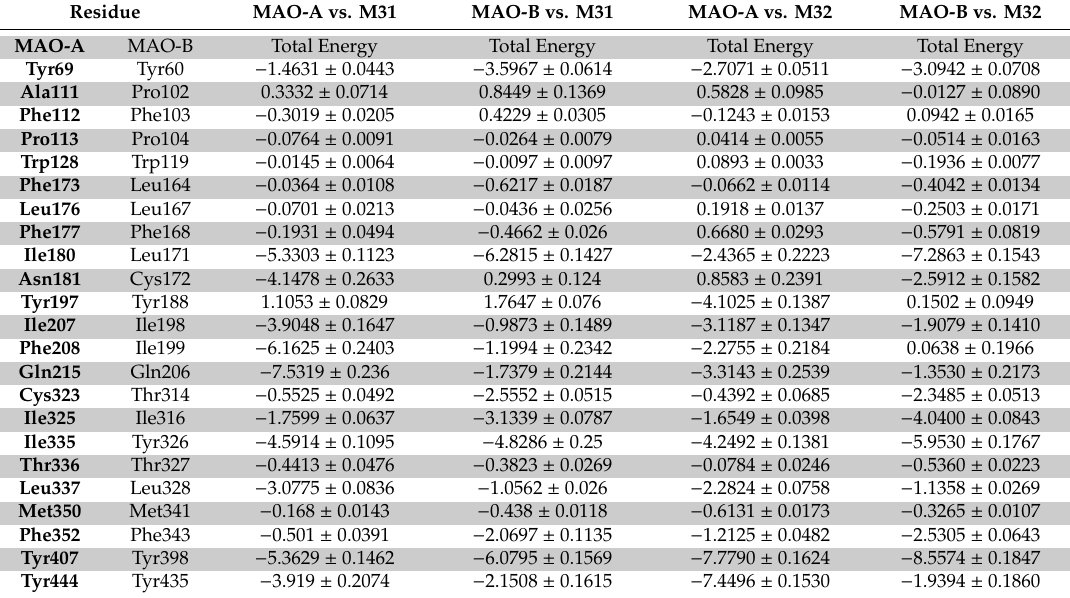
Table 3. Free energy contributions (kJ / mol) of h MAO-A and h MAO-B pocket